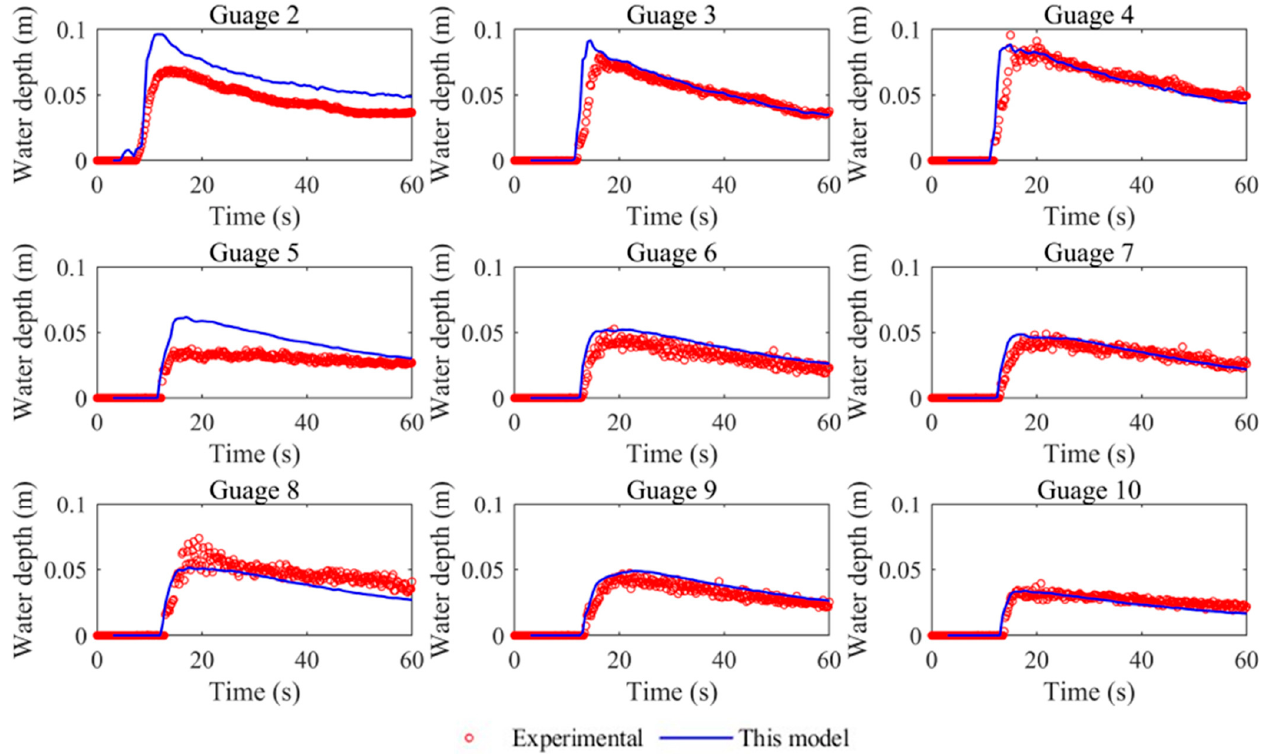
Figure 14. Simulated and measured water depths at nine sample gauges.